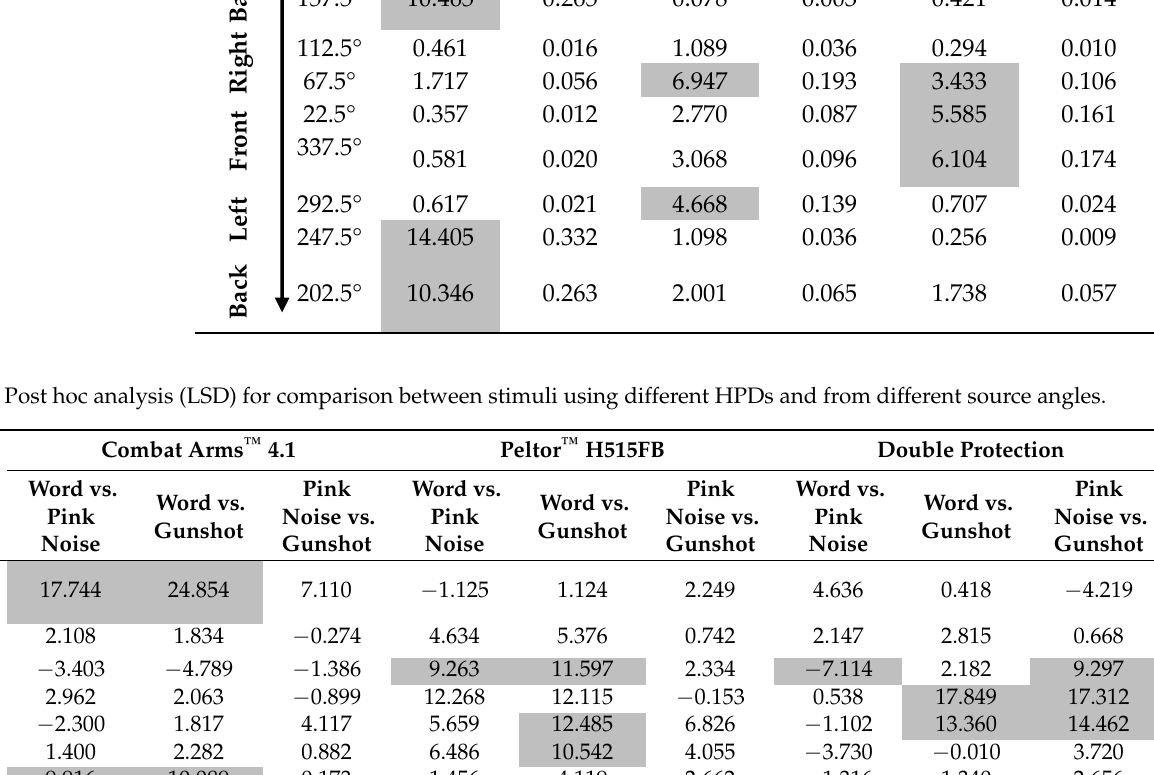
Combat Arms ™ 4.1 Word vs.